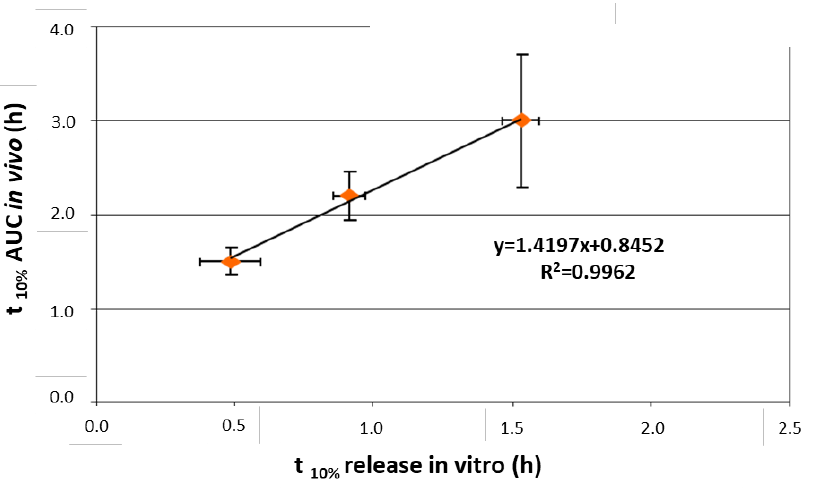
Figure 27. Mean salivary paracetamol concentration profiles after oral administration of Klucel ® LF- based Chronocap TM systems having different thicknesses. Bars represent standard deviation. Adapted with permission from Ref. [67].